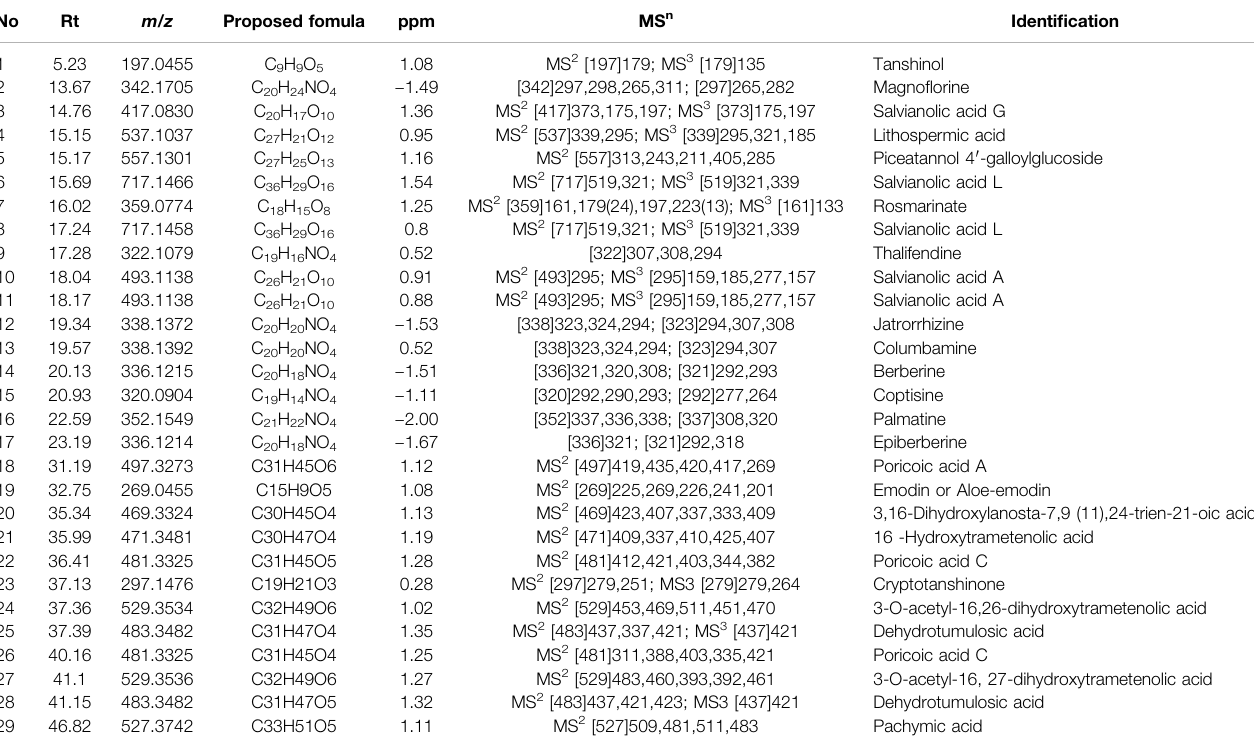
TABLE 1 | Related chromatographic mass spectrometric data of compound in naofucong granule.